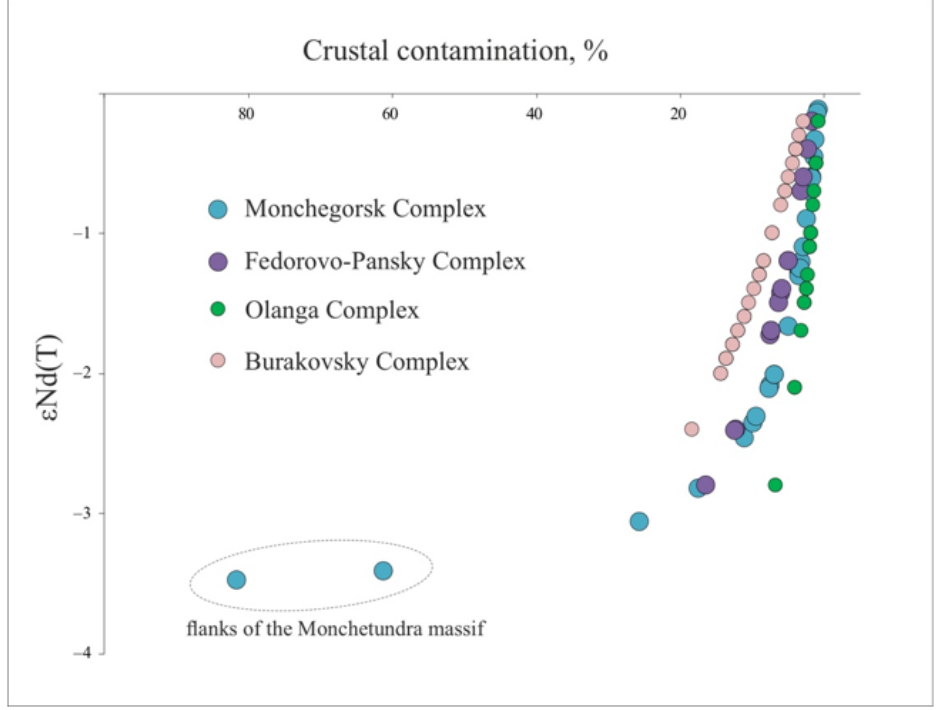
Figure 12. Contribution of the crustal component (crustal contamination) in the rocks of the layered intrusions of the Fennoscandian Shield. Data for the Burakovsky intrusion and the Olanga group from [70].